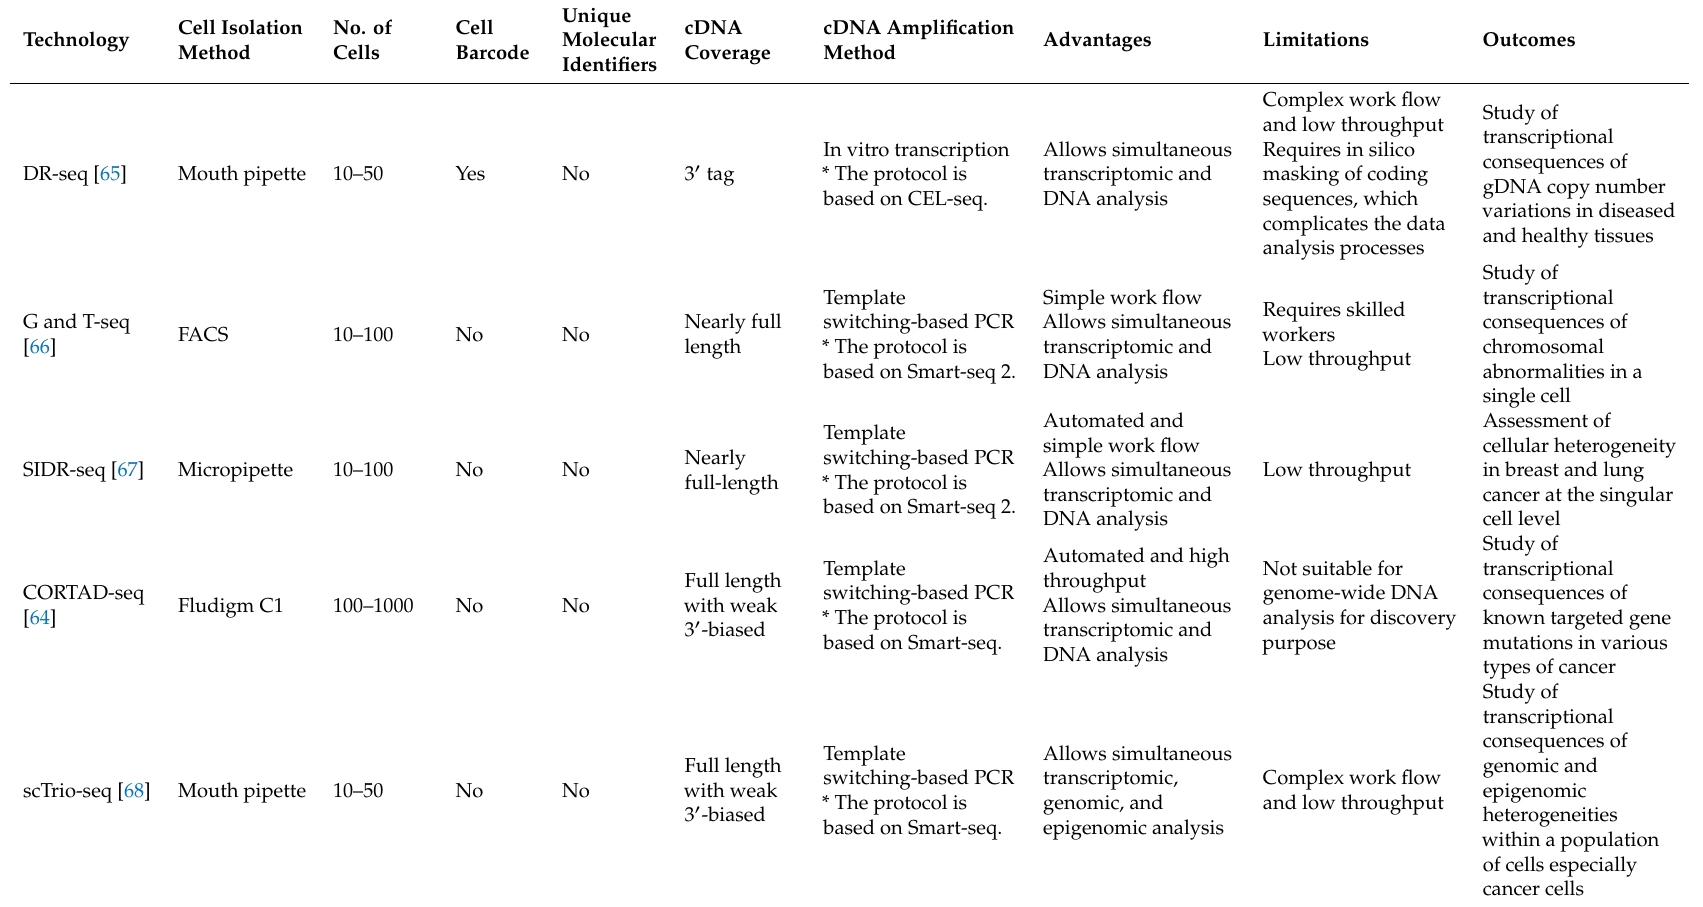
Table 4. Summary of integration of scRNA-seq with DNA